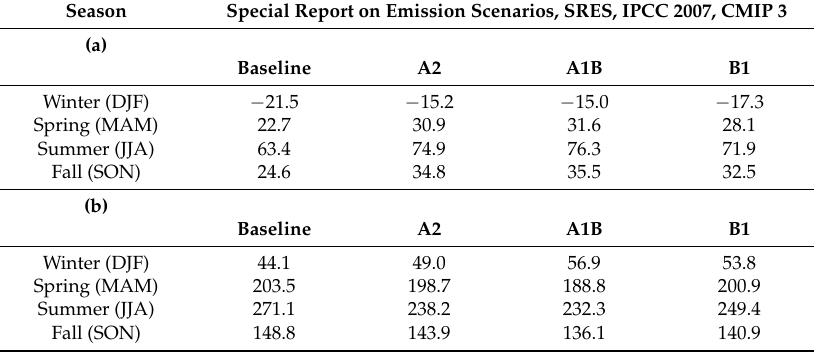
Table A6. Seasonal variations in projected climate change scenarios (based on the Special Report on Emission Scenarios, SRES, IPCC 2007, CMIP 3 † ) for the mid-21st century (2046–2065) in SKW with the baseline (1987–2000): ( a ) Temperature; ( b )